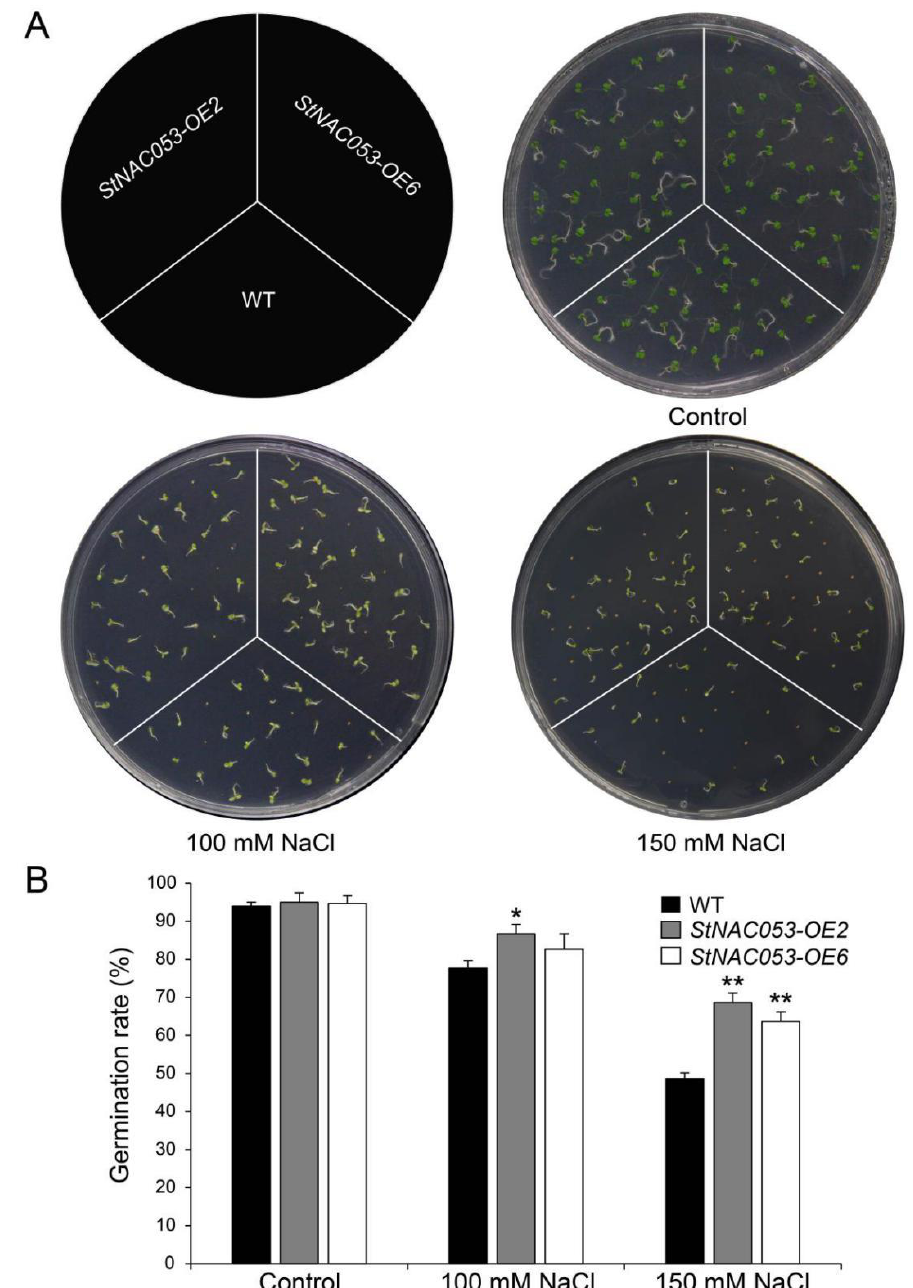
Figure 7. Comparison of seed germination between StNAC053 overexpressing and wild-type Ara- bidopsis under salt stress treatments. ( A ) Seed germination assay between StNAC053 overexpression and wild-type Arabidopsis under 100 and 150 mM NaCl treatments. The seed germination rates were recorded six days after sowing. ( B ) The statistics of seed germination under normal condition, 100 and 150 mM NaCl treatments. WT, wild-type. The data were means ± SD from three independent replications. * p < 0.05, ** p <0.01 ( t -tests).